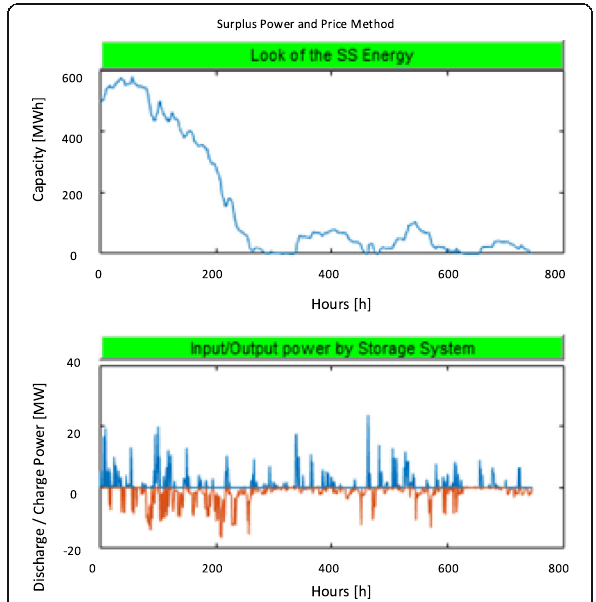
Fig. 5 Sizing ESS with Surplus Power and Price Method with PtG